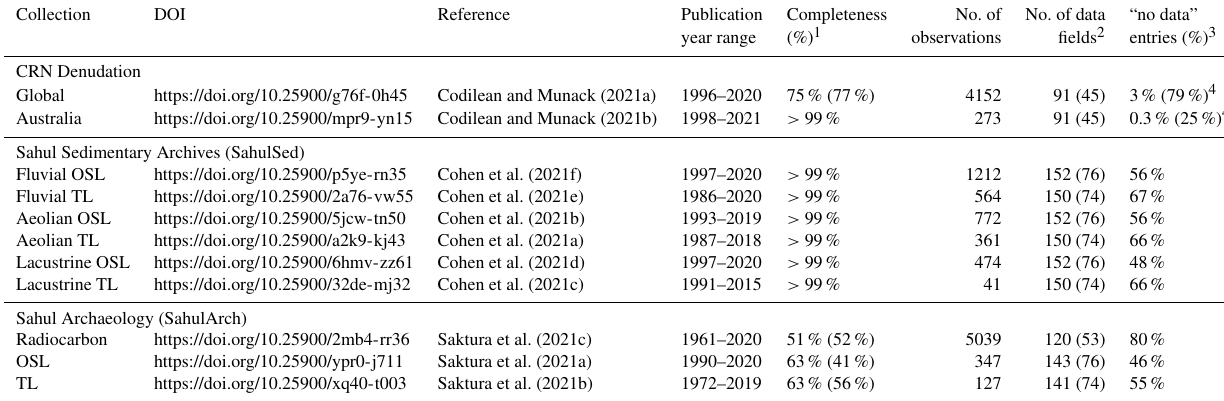
Table 1. Summary of the OCTOPUS v.2 core data collections and